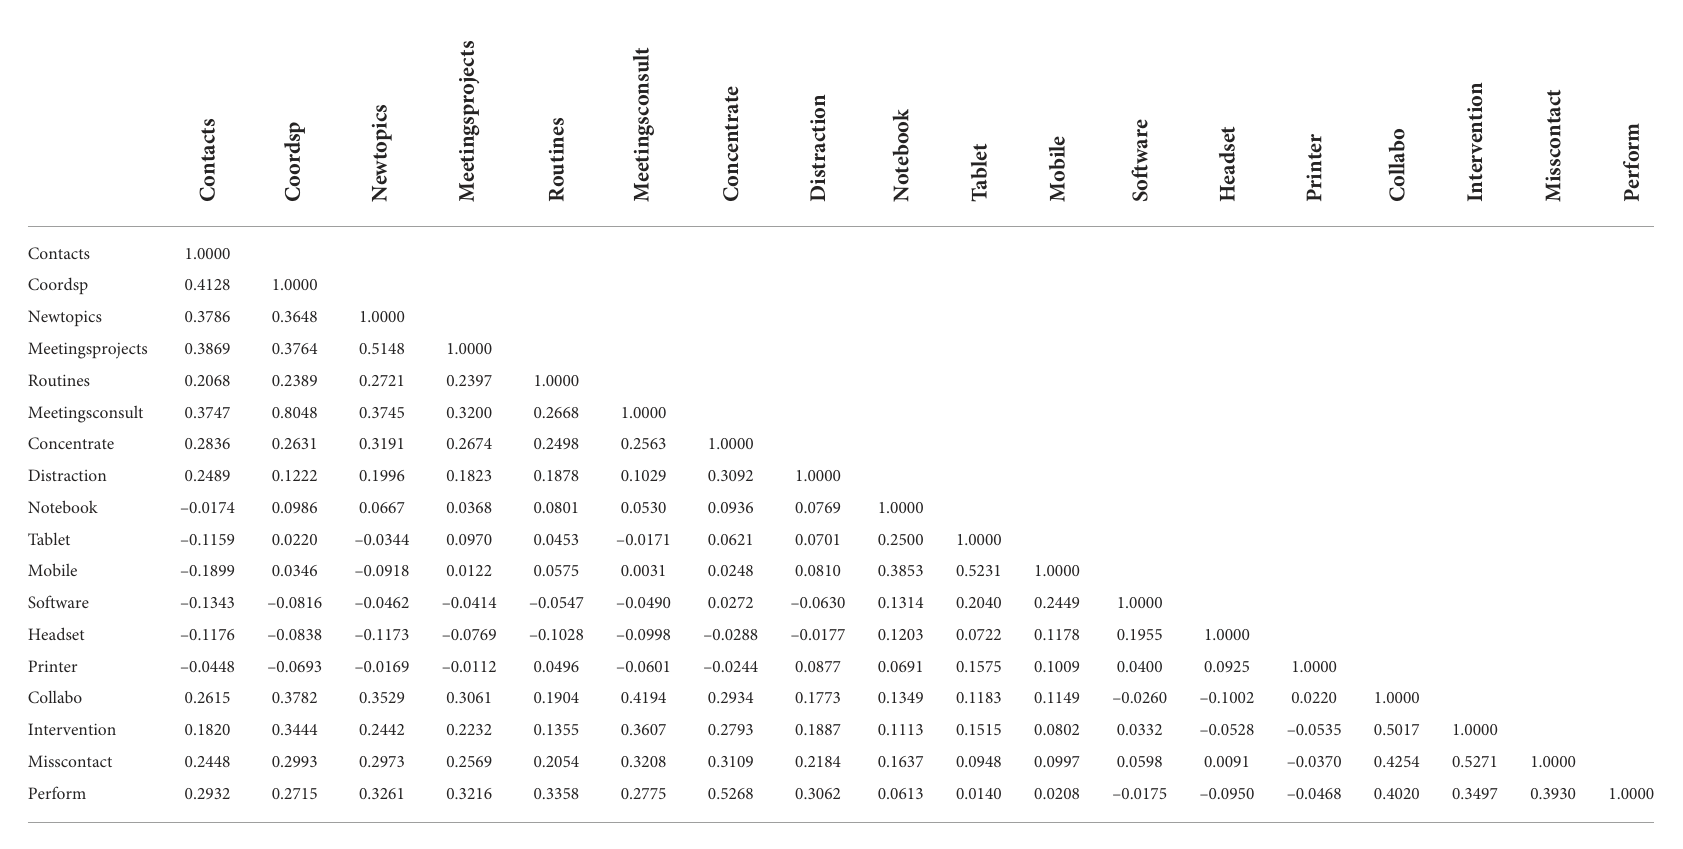
TABLE A1 Empirical correlation